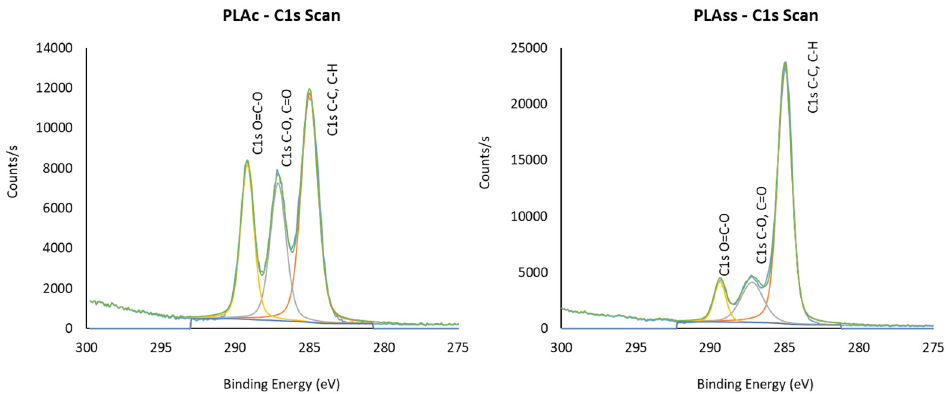
Figure 2. XPS high resolution spectra for C1s of printed PLA control (PLAC) and PLA sterilised with saturated steam (PLA SS ).